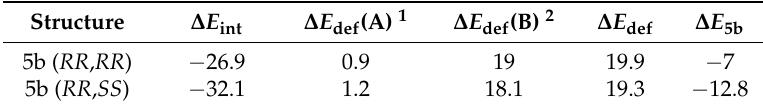
Table 1. The energy decomposition of 5b